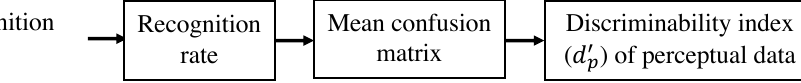
Figure 5. Process of calculating the discrimination index of experimental